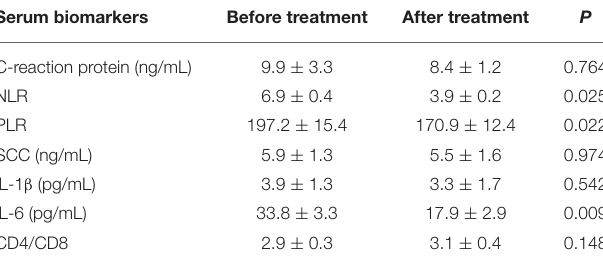
between before immuno-chemotherapy and after cycles of immuno-chemotherapy.